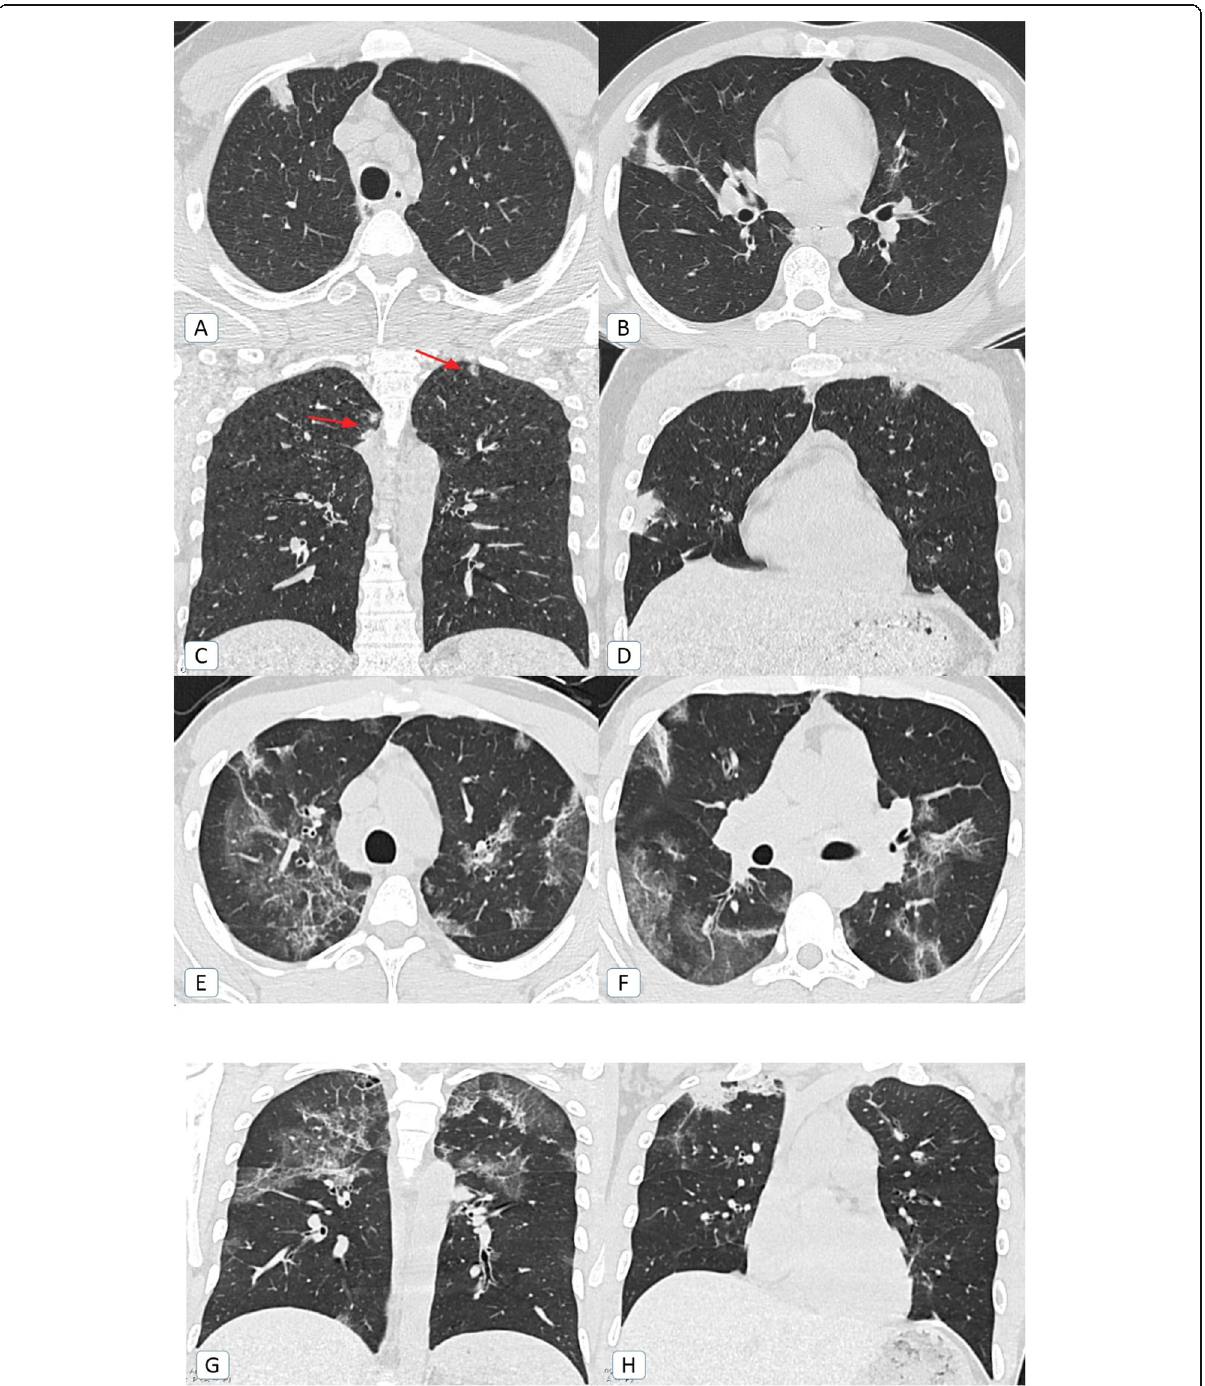
Fig. 12 COVID-19 reinfection: A 35-year-old male COVID-19 patient. A , B Axial, and C , D coronal chest CT (lung window) during the mild first infective episode at the beginning of October 2020, showing small bilateral upper lobar mixed ground glass and consolidative patches. E , F Axial and G , H and coronal chest CT (lung window) during the more severe reinfection at the end of March 2021, showing widespread bilateral upper and lower lobar mixed ground glass and consolidative patches with fibro-atelectatic changes. Also noted right apical mild cystic changes as a sequel to the previous